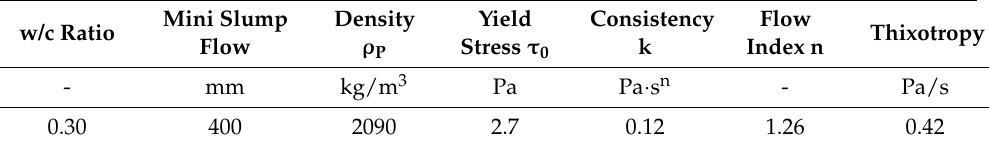
Table A1. Properties of the cement paste.